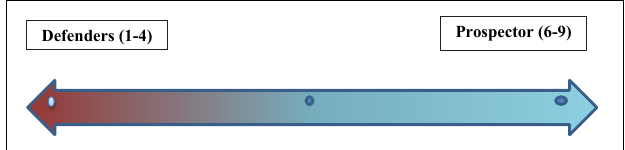
FIGURE 2 | The continuum of the business